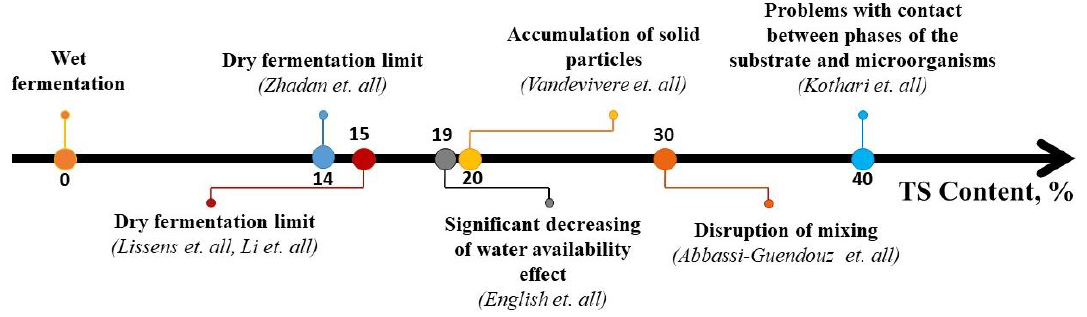
Figure 3. Influence of TS increase on the methane fermentation of chicken manure.